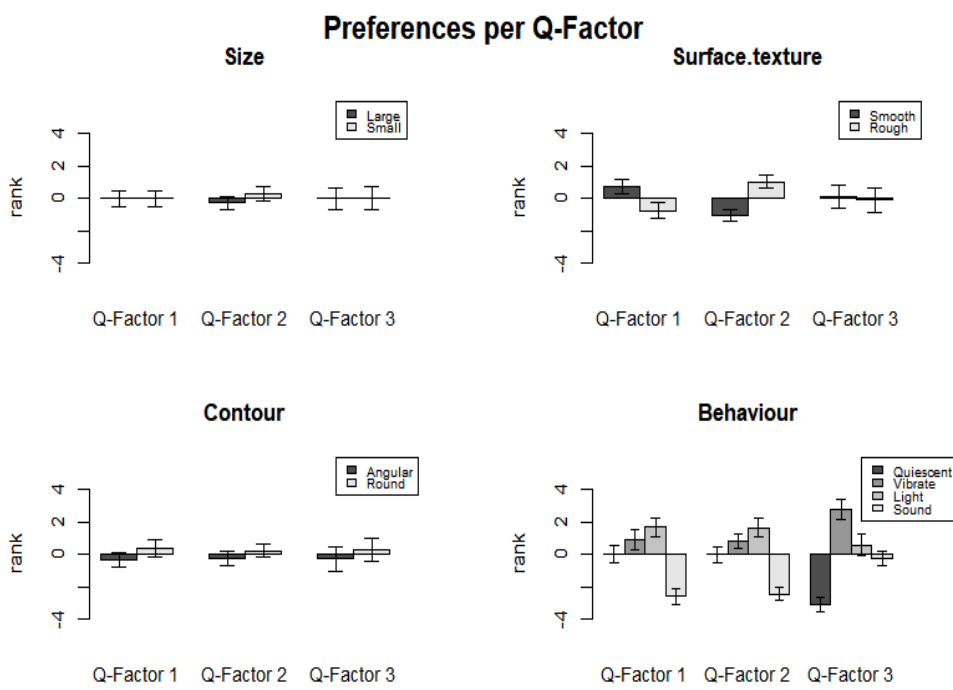
Figure 11. The preference of variables for each Q-factor.